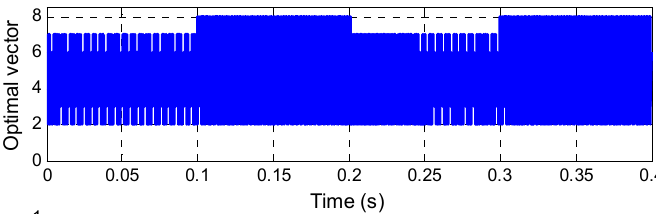
Figure 10. Optimal switching vector with the unmodulated FCS-MPC.